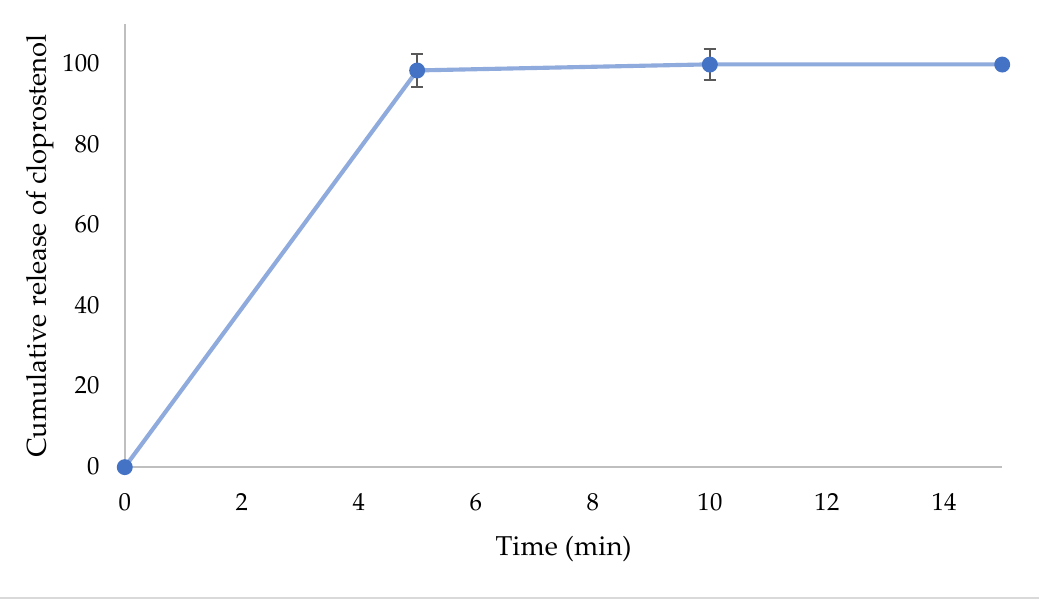
Figure 5. In vitro release profile of cloprostenol IR formulation. Each data point is the mean ± standard deviation of the triplicate.